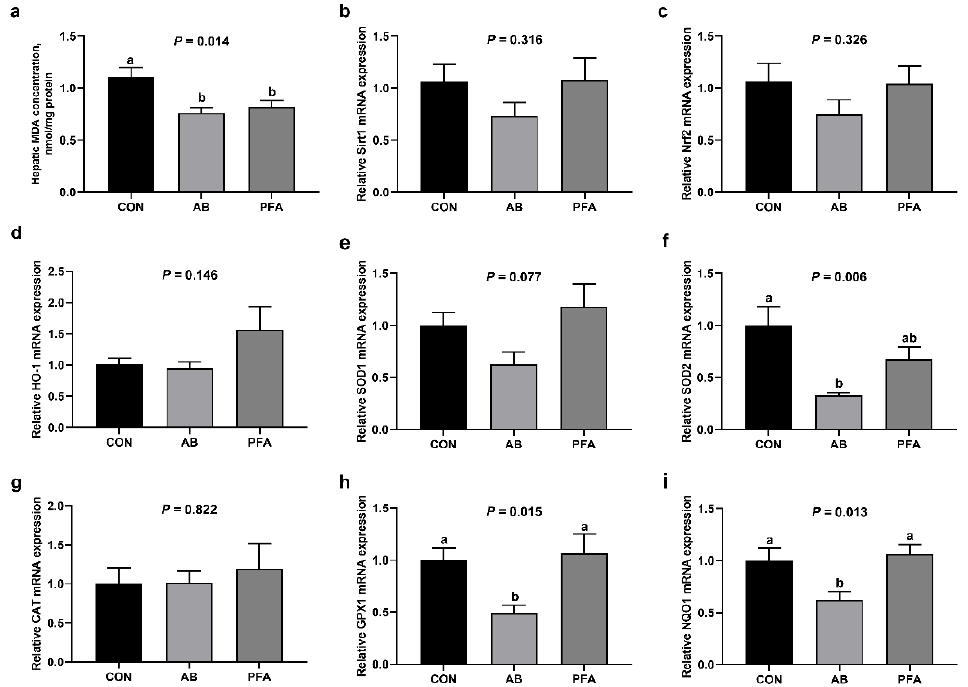
Figure 5. Effects of paraformic acid (PFA) supplementation on hepatic MDA concentration and antioxidant genes expressions in broiler chickens. ( a ) MDA, malondialdehyde; ( b ) Sirt1, sirtuin 1; ( c ) Nrf2, necrosis-related factor 2; ( d ) HO-1, heme oxygenase-1; ( e ) SOD1, superoxide dismutase-1; ( f ) SOD2, superoxide dismutase-2; ( g ) CAT, catalase; ( h ) GPX1, glutathione peroxidase-1; ( i ) NQO1, NADPH quinone oxidoreductase 1. CON, broiler chickens receiving basal diet; AB, broiler chickens receiving basal diet supplemented with 50 mg/kg aureomycin; PFA, broiler chickens receiving basal diet supplemented with 1000 mg/kg PFA. Results are presented as mean ± SEM ( n = 7). a,b Means with different superscripts differ ( p < 0.05).